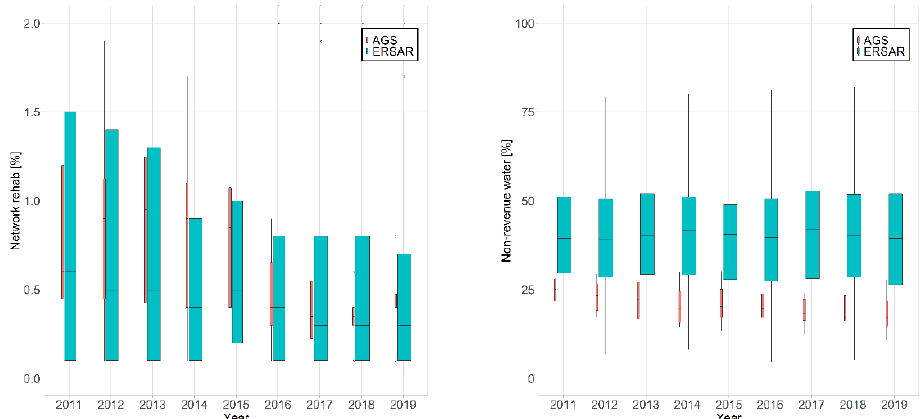
Figure 1. Box–whisker plots depicting distribution of data points in the period of 2011 to 2019. The width of the boxes is proportional to the total number of data points. Outliers are depicted as crosses (x). ( Left ) Percentage of network rehabilitated per year. ( Right ) Non-revenue water.